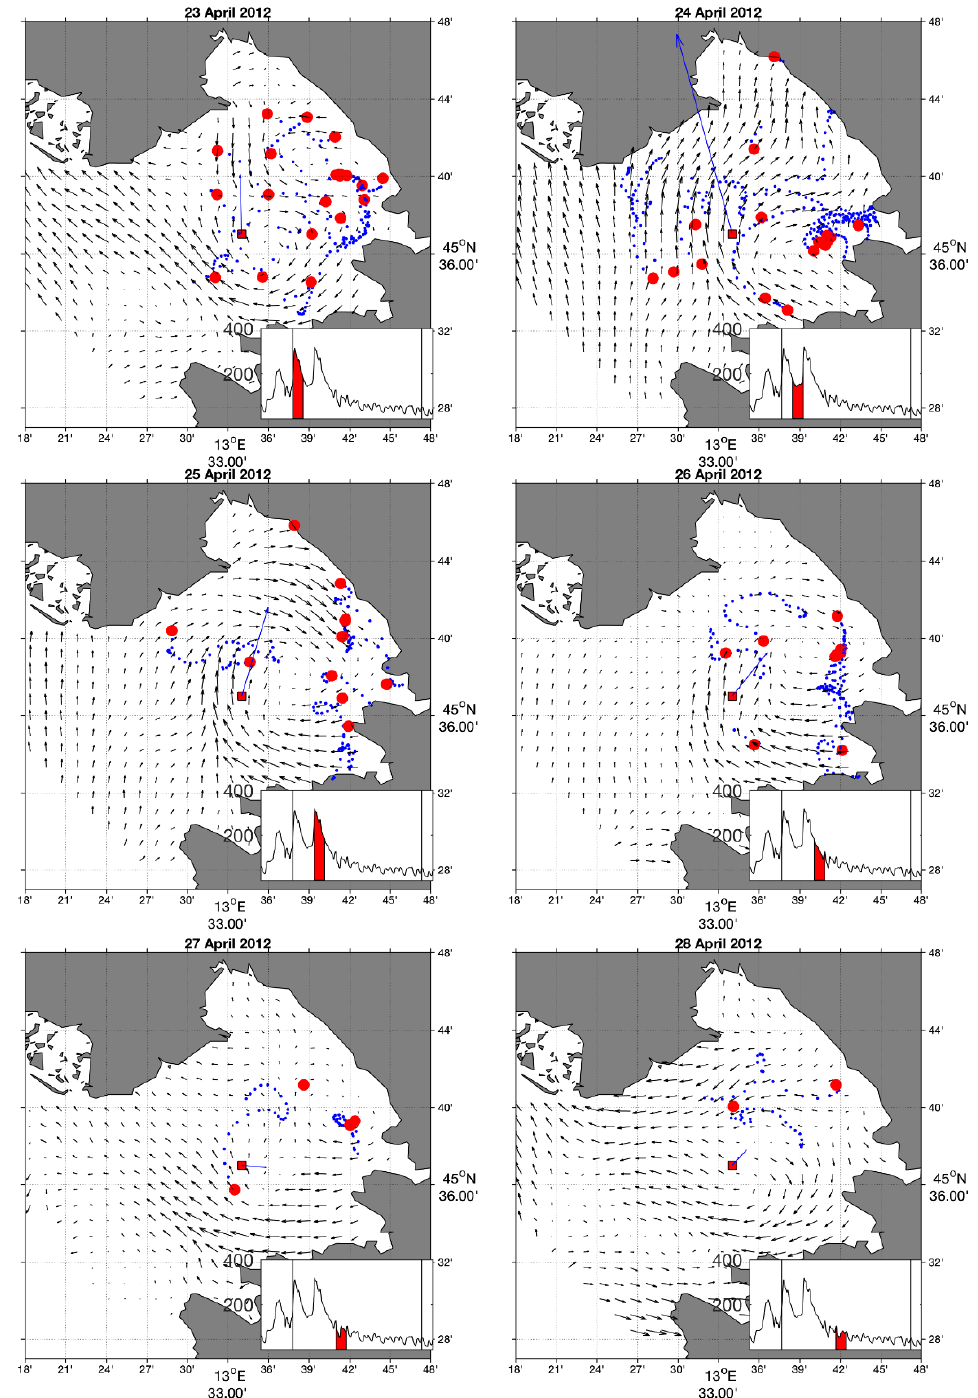
Figure 3. Daily averaged surface current patterns from HFR measurements for the April 2012 TOSCA experiment, along with cumulative daily drifter trajectories (hourly positions), for the time period of 23–28 April. Red circles correspond to the “seeding” point for each drifter at the beginning of the day. The inset in each plot provides indication of the freshwater discharge. The blue arrow shows daily averaged wind within the